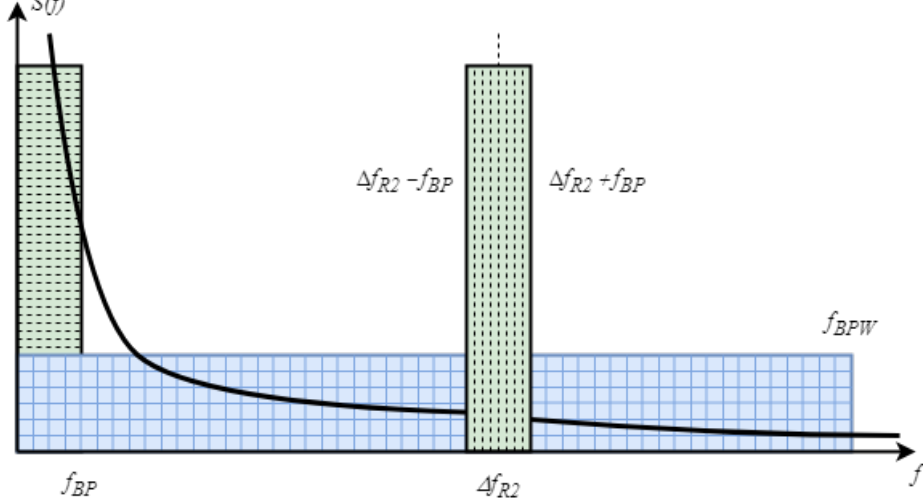
Figure 7. Explanation of SNR gain using detection at an intermediate frequency, compared with direct detection (adapted from [26]).